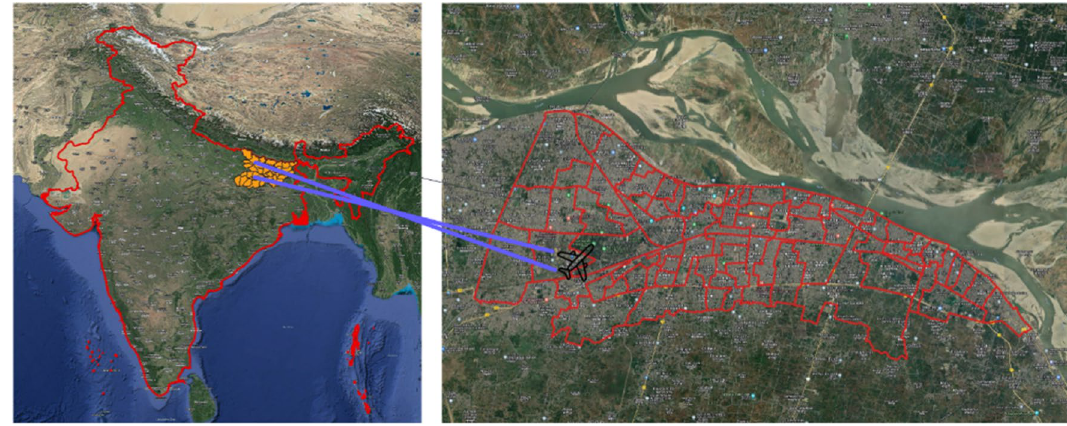
Fig. 1 The geographical location of Jay Prakash Narayan International Airport Patna ( a ) India ( b ) Capital Cities of Patna and its